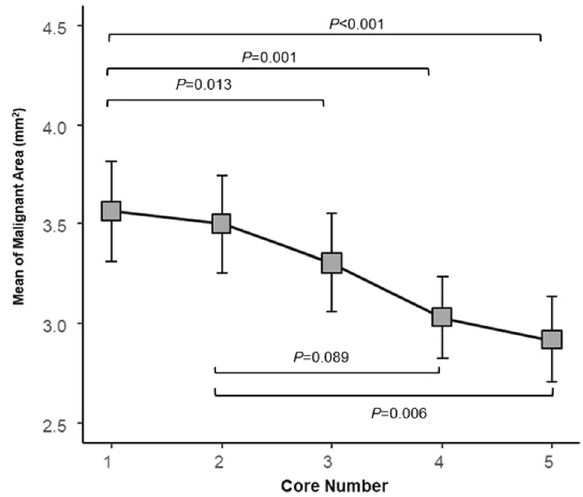
Fig. 2 Comparison of malignant area content by core number. The fi gure shows the mean of the malignant area with SD. p Values are from Tukey adjusted methods controlling for